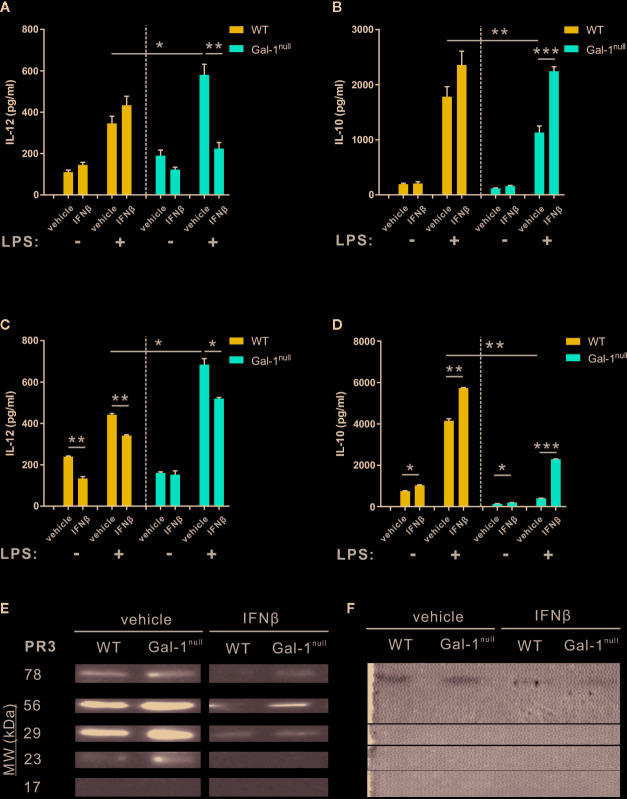
IFN-β rescues hampered keys of resolution of inflammation in Gal-1null mice. (A, B) WT and Gal-1null male mice undergoing peritonitis were administered with IFN-β or vehicle 24 h PPI, and their peritoneal exudates were collected 24 h later. Macrophages were isolated from the exudates and exposed to vehicle or LPS for 24 h. (C, D) Peritoneal macrophages were isolated from WT and Gal-1null male mice 66 h PPI. Then, the macrophages were treated with IFN-β or vehicle, and in parallel exposed to vehicle or LPS for 24 h. The concentrations of the following cytokines and chemokines were measured in the culture media by ELISA: (A, C) IL-12, and (B, D) IL-10. (E, F) Mice were administered with IFN-β or a vehicle 24 h PPI, and peritoneal exudates were collected 48 h PPI. (E) Equal volumes of cell-free fluids were run by SDS-PAGE, followed by immunoblotting for PR3; representative blot images. (F) Proteolytic activity of PR3 in exudates was examined by casein zymography; representative gel images are shown. Full blot and zymography images are shown in
Figure S13
. Data are representative of two to three independent experiments and are presented as mean ± SEM, n = 4–8. Statistical significance relative to vehicle-treated mice or between LPS-stimulated WT and Gal-1null macrophages was analyzed by two-tailed Student's t-test; *p < 0.05, **p < 0.01, ***p < 0.001.